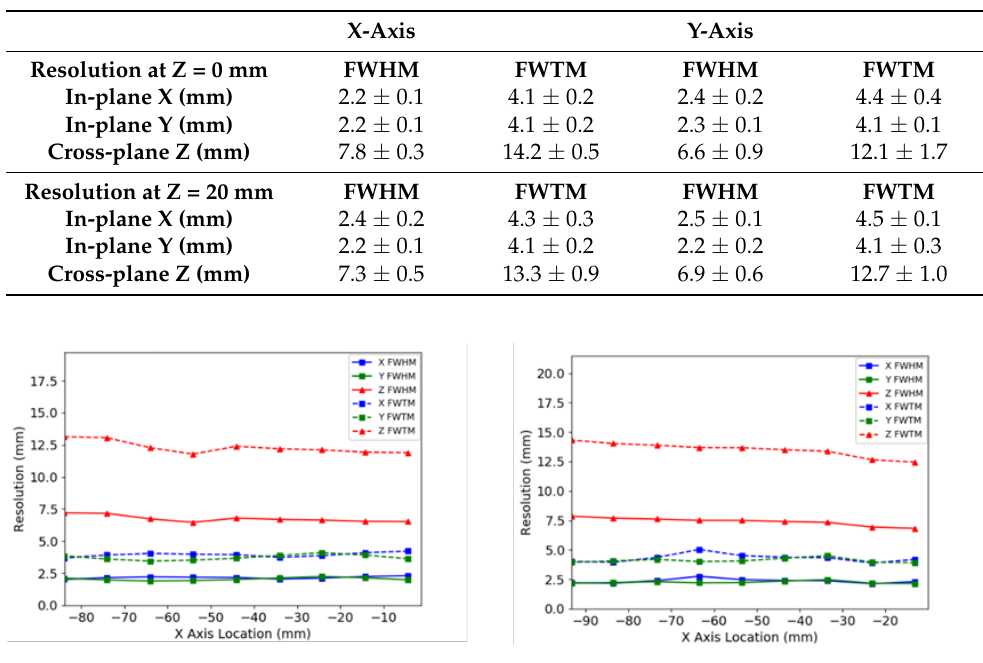
Figure 5. System spatial resolutions produced with the MLEM reconstruction. Left: the central Z-axis resolution plotted as a function of point-source location along the X-axis. Right: the quarter Z-axis resolution plotted as a function of point-source location along the X-axis.